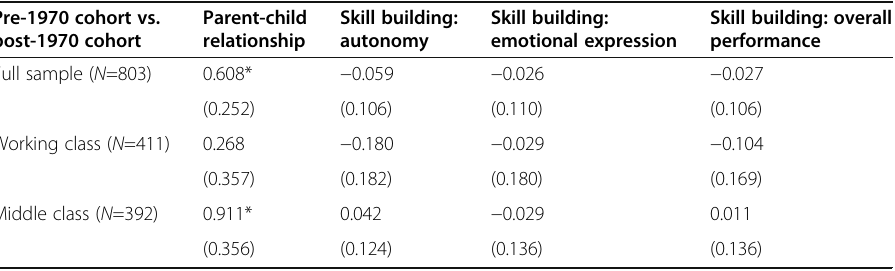
Table 6 Ordinal logistic regressions on the parent-child relationship and multivariate linear regressions on skill building in the SHFS 2010 Pre-1970 cohort vs. post-1970